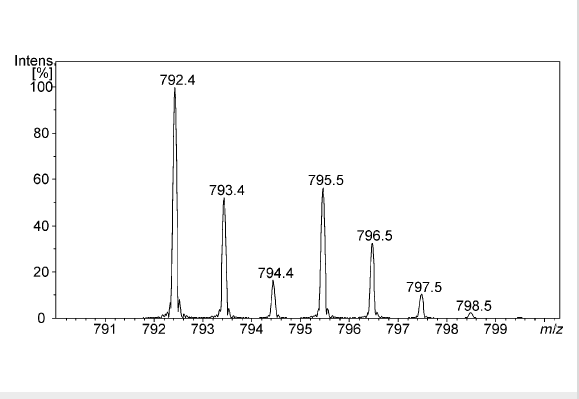
Figure 4: ESI-mass spectrum (positive mode) of a 1:1:1 mixture of 1 , protonated L-leucine methyl ester (LeuOMe), and protonated L-isoleucine trideuteromethyl ester (IleOMe- d 3 ) in a 1:1 mixture of CH 2 Cl 2 /MeOH ( m / z = 792.4 LeuOMe– 1 , m / z = 795.5 IleOMe- d 3 – 1 ).